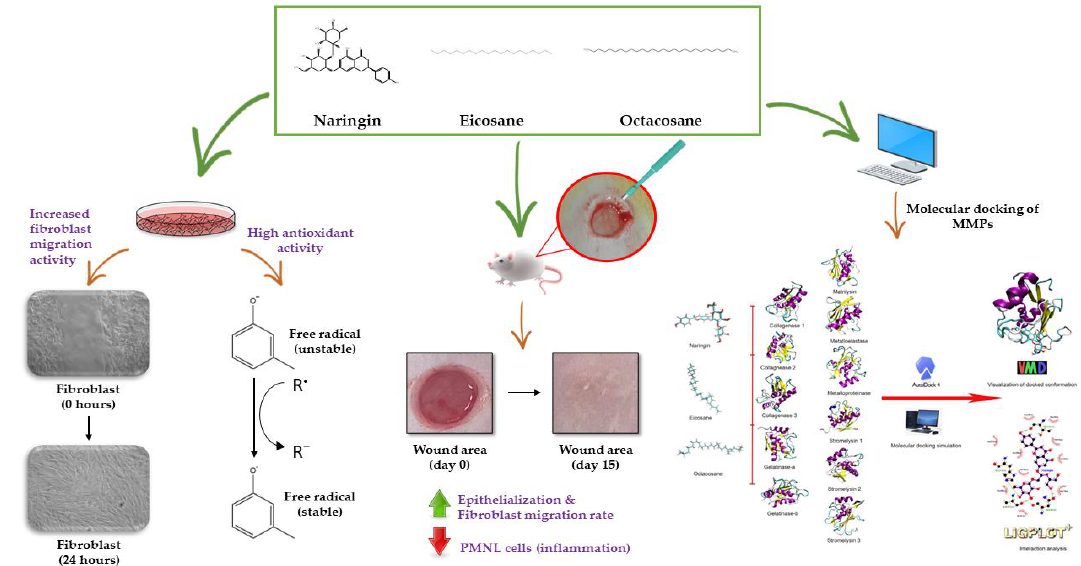
Figure 12. Mechanism of action of naringin, eicosane and octacosane through the in vitro and in vivo models, and the molecular docking of these compounds with the MMPs involved in wound healing.